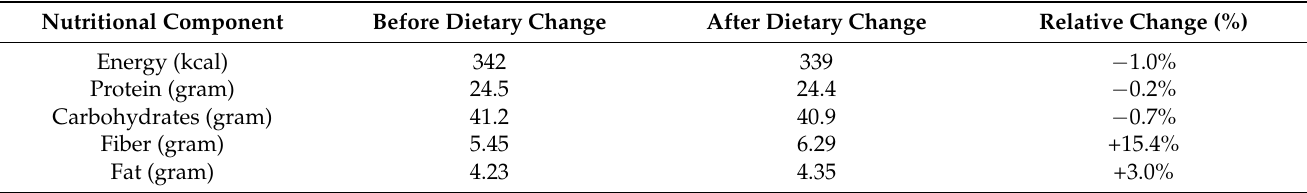
Table 2. Average daily intake of energy, protein, carbohydrates, fiber, and fat before and after dietary change in adult female long-tailed